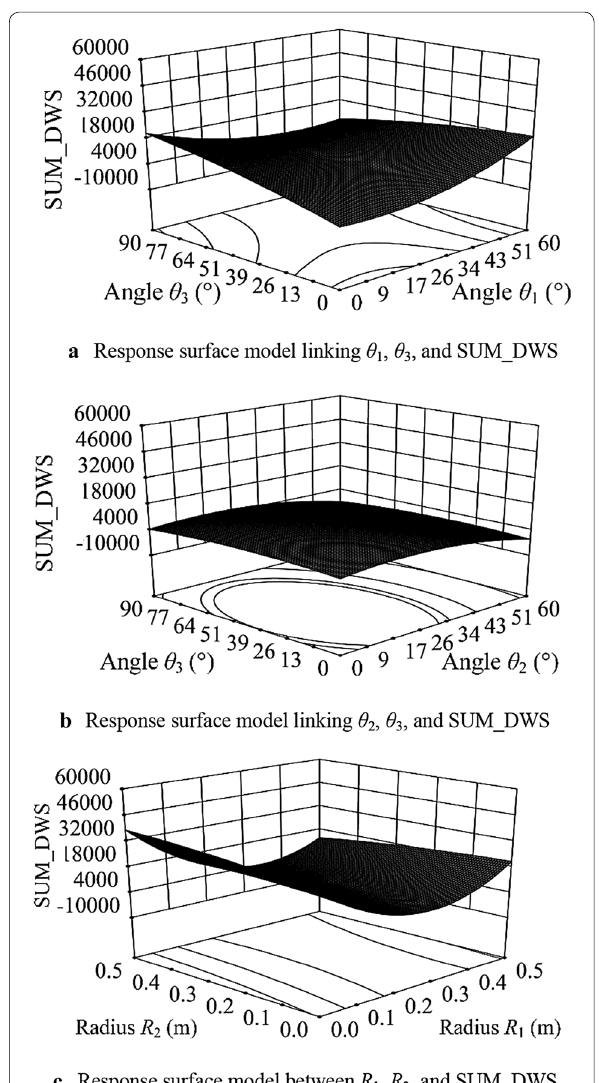
Figure 5 Response surface